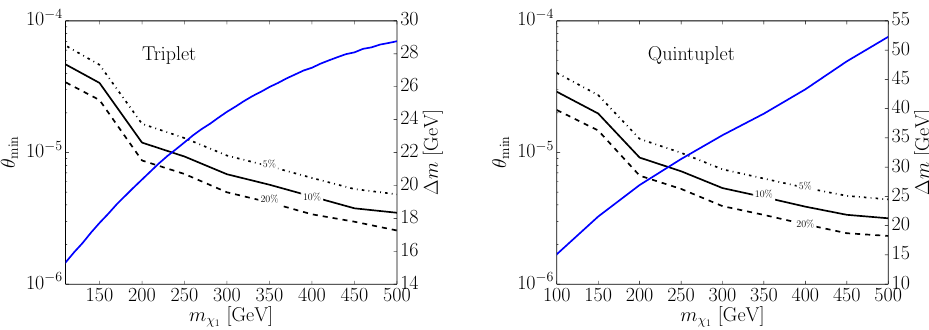
Figure 1 . In black, left vertical axes: the minimal angle for the triplet (left) and quintu- plet (right) case which it is appropriate to calculate the relic density via the freeze-out of the coannihilation process. The three black curves indicate the values of the mixing angle which result in a 5% (dash-dotted), 10% (solid) and 20% (dashed) deviation of the (cid:31) 1 number den- sity from its equilibrium value as the coannihilation processes freeze out at x f In blue, right vertical axes: the predicted mass splitting between the n -plet and singlet masses to obtatin the correct relic density through coannihilation as a function of the mass. Note that this is e(cid:11)ectively independent of the mixing angle (cid:18) as long as (cid:18) is small enough to neglect